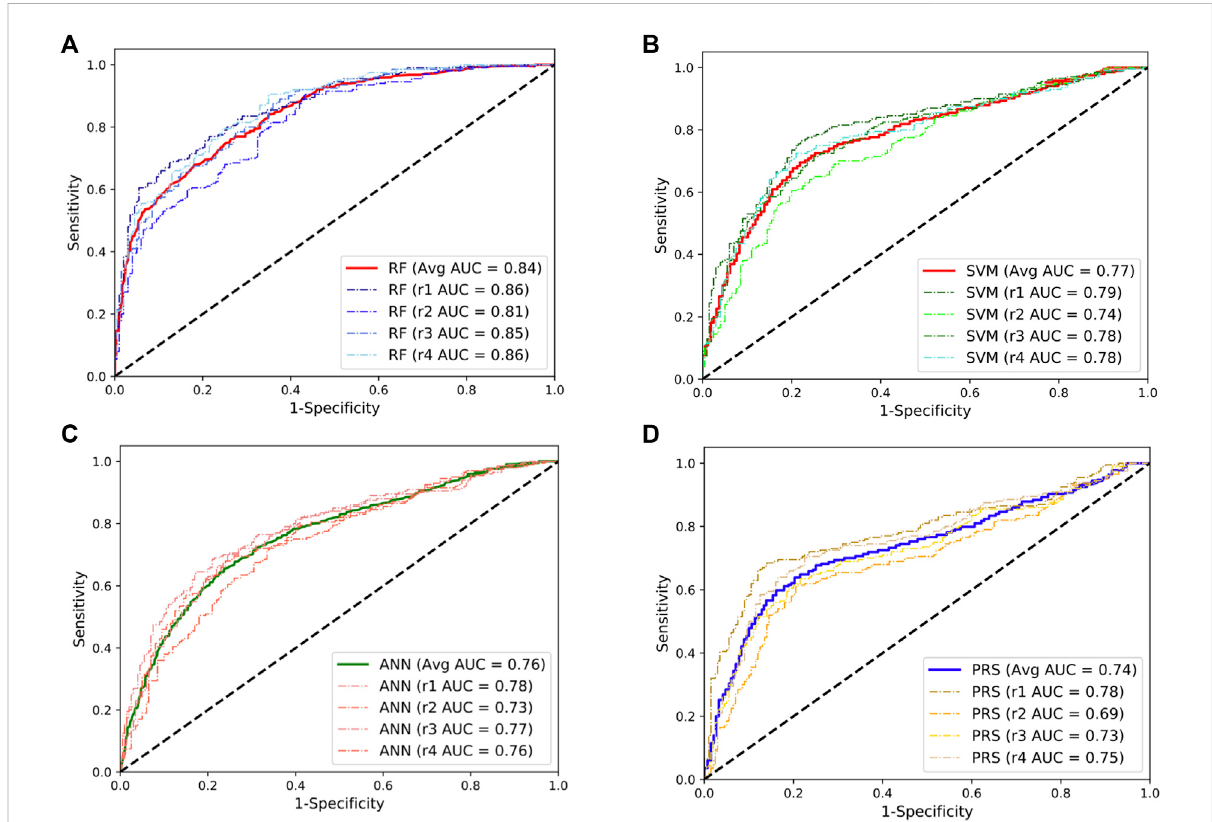
FIGURE 1 Performances of the random forests (RF; (A) ), support vector machine (SVM; (B) ), arti fi cial neural network (ANN; (C) ), and the lassosum-based polygenic risk scoring (PRS) model (D) in predicting the development of SLE in Chinese population. The dashed line indicates the performance for each repeat. The solid lines indicate the averaged performance among the four